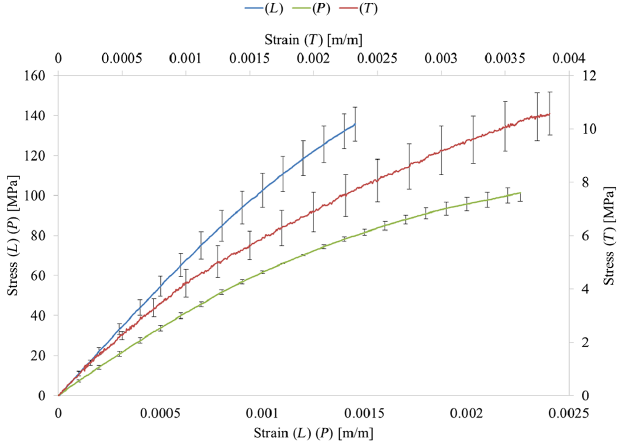
FIG. 17. Plot of flexural stress against strain for CFC. Longi- tudinal data and relevant axes marked with ( L ). Transverse data and relevant axes marked with ( T ). Perpendicular data and relevant axes marked ( P ).